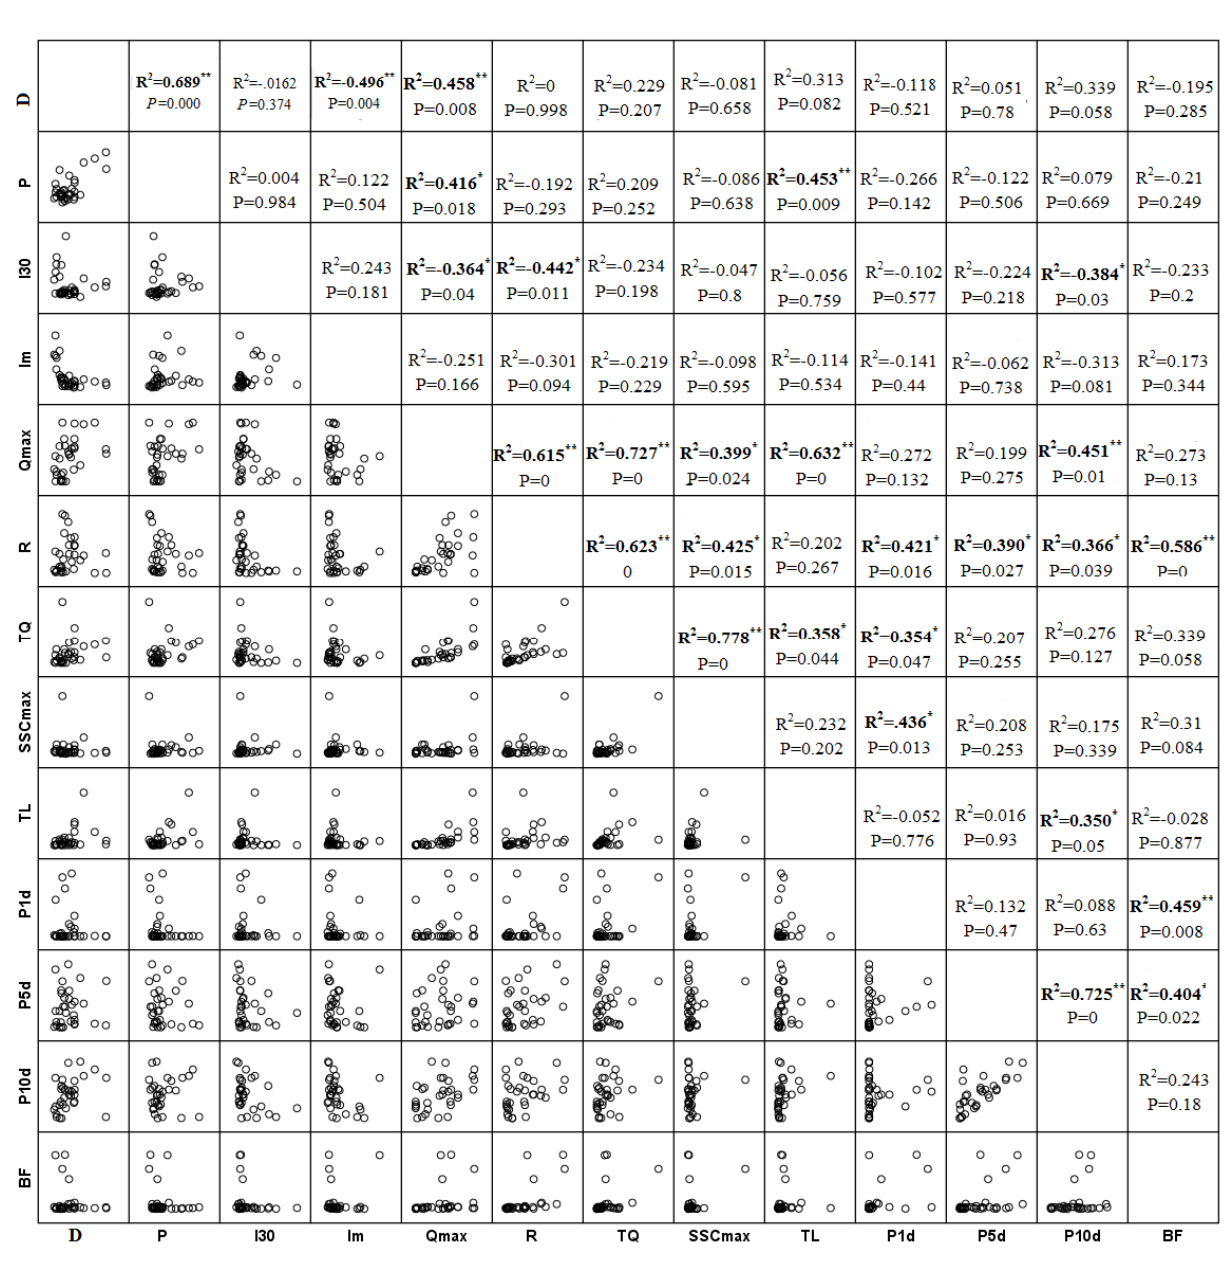
Figure 3. Bivariate scatter plot matrix of selected event characteristics. Note: ** means very significant levels ( p < 0.01), and * means significant levels ( p <